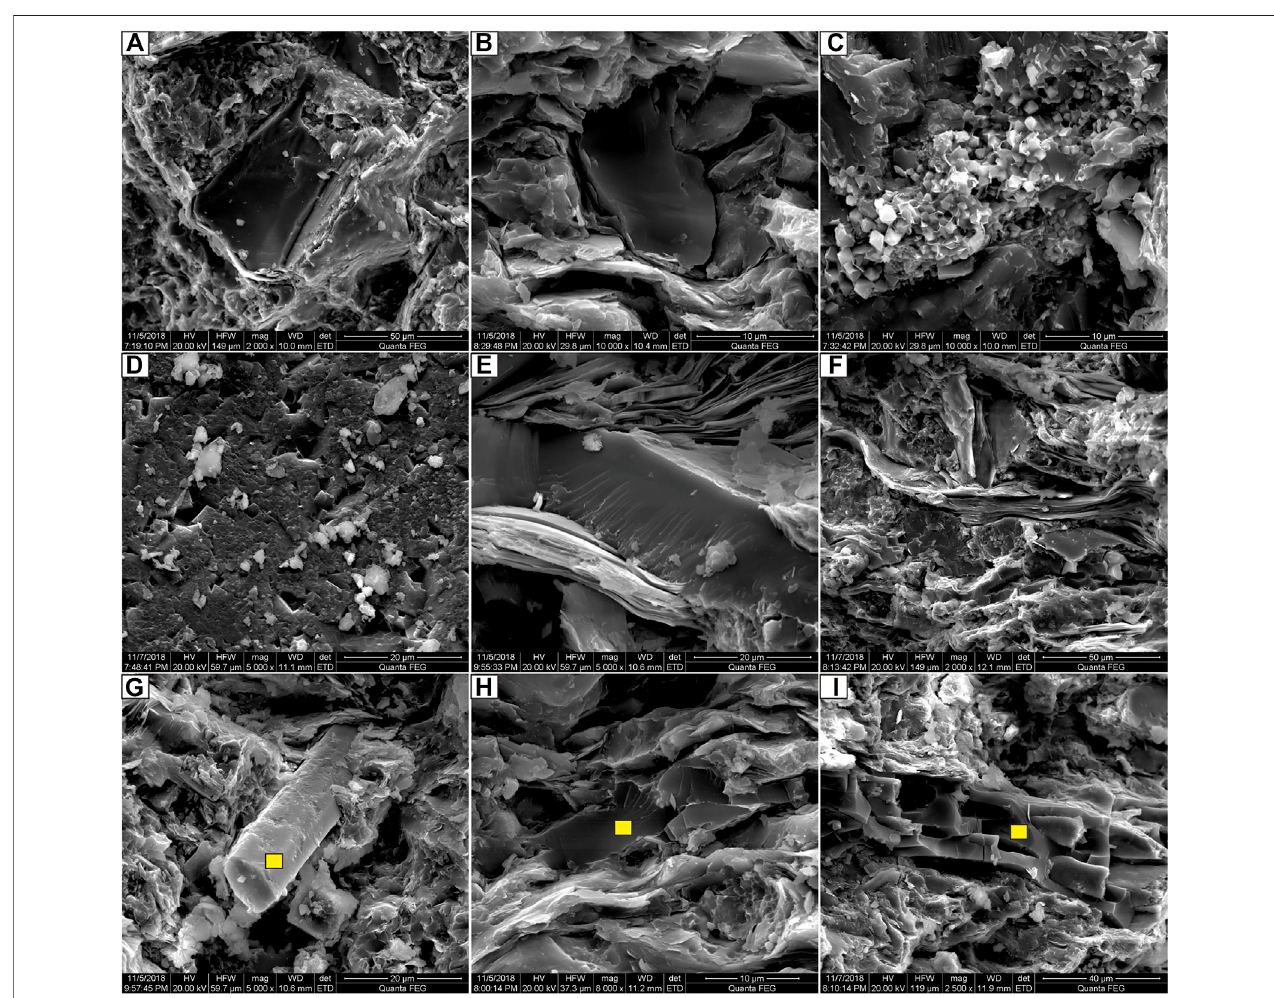
FIGURE 8 | FESEM images, energy spectrum, and thin-section photomicrographs of the Upper Carboniferous Keluke transitional shales. (A) Siliceous grains and associatedpores. (B) Micro-scale organicmatter(coalcuttings),interparticlepores. (C) Nano-scale pyriteaggregate. (D) Calciteand associatedintergranular pores. (E) Siliceous grains, slit-like minerals, and associated pores. (F) Slit-like minerals (chlorite and mica), coal seam intermixed with grained minerals (carbonate minerals), interparticle pores. (G) Columnar minerals (detrital aluminate minerals) and alteration products. (H) Micro-scale organic matter (coal cuttings), short stripe along bedding,interparticlepores,noporeinorganicmatter. (I) Coalcuttings(fusinite)intermixedwithmudstone(clayminerals). (J – L) energyspectrumsofmineralsmarkedby yellow boxes in (G – I) , respectively. (M) Pyrites and associated pores, fractures along bedding. (N) Nano-scale dissolution pores in calcite. (O) Broken organic matter (coal and vitrinite) and conchoidal fracture. (P) Organic matter and its internal structure show nano-scale spherical structure (asphaltite?). (Q,R) Fractures and laminas.